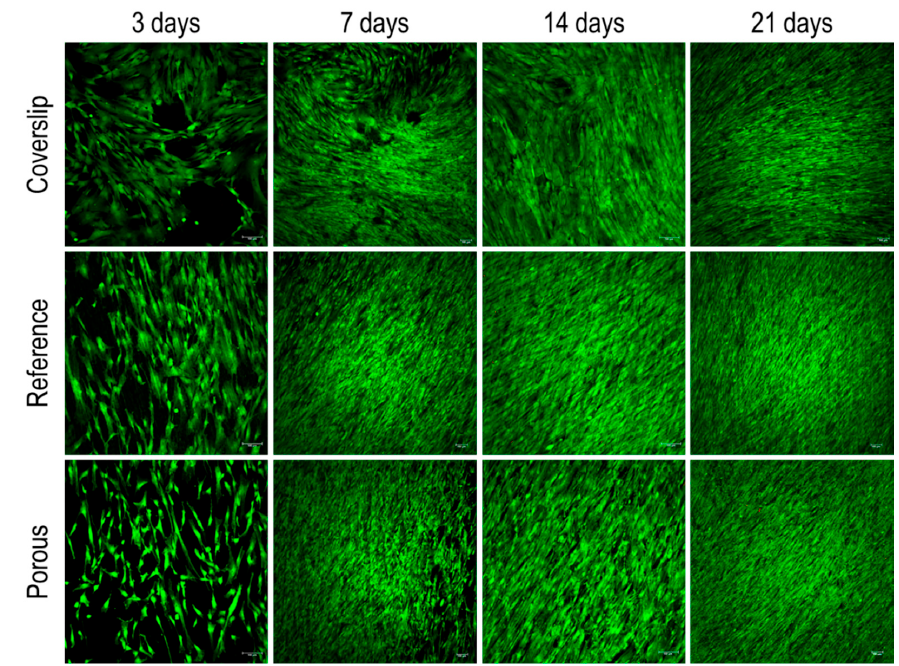
Figure 8. Representative fluorescence images of human umbilical cord perivascular cells (HUCPVCs) cultured on porous (dealloyed) and reference (non-dealloyed) samples. Fluorescence LIVE (green)/DEAD (red) staining was performed after 3, 7, 14, and 21 days of cell culturing. For interpretation of the references to color in this figure legend, the reader is referred to the web version of this article.